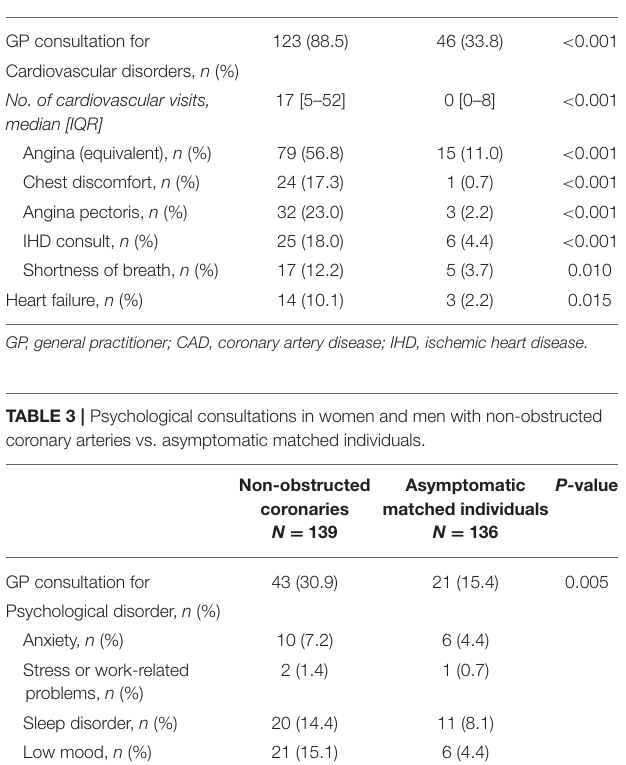
TABLE 2 | Cardiovascular consultations in women and men with non-obstructed coronary arteries vs. asymptomatic matched individuals. Non-obstructed coronaries